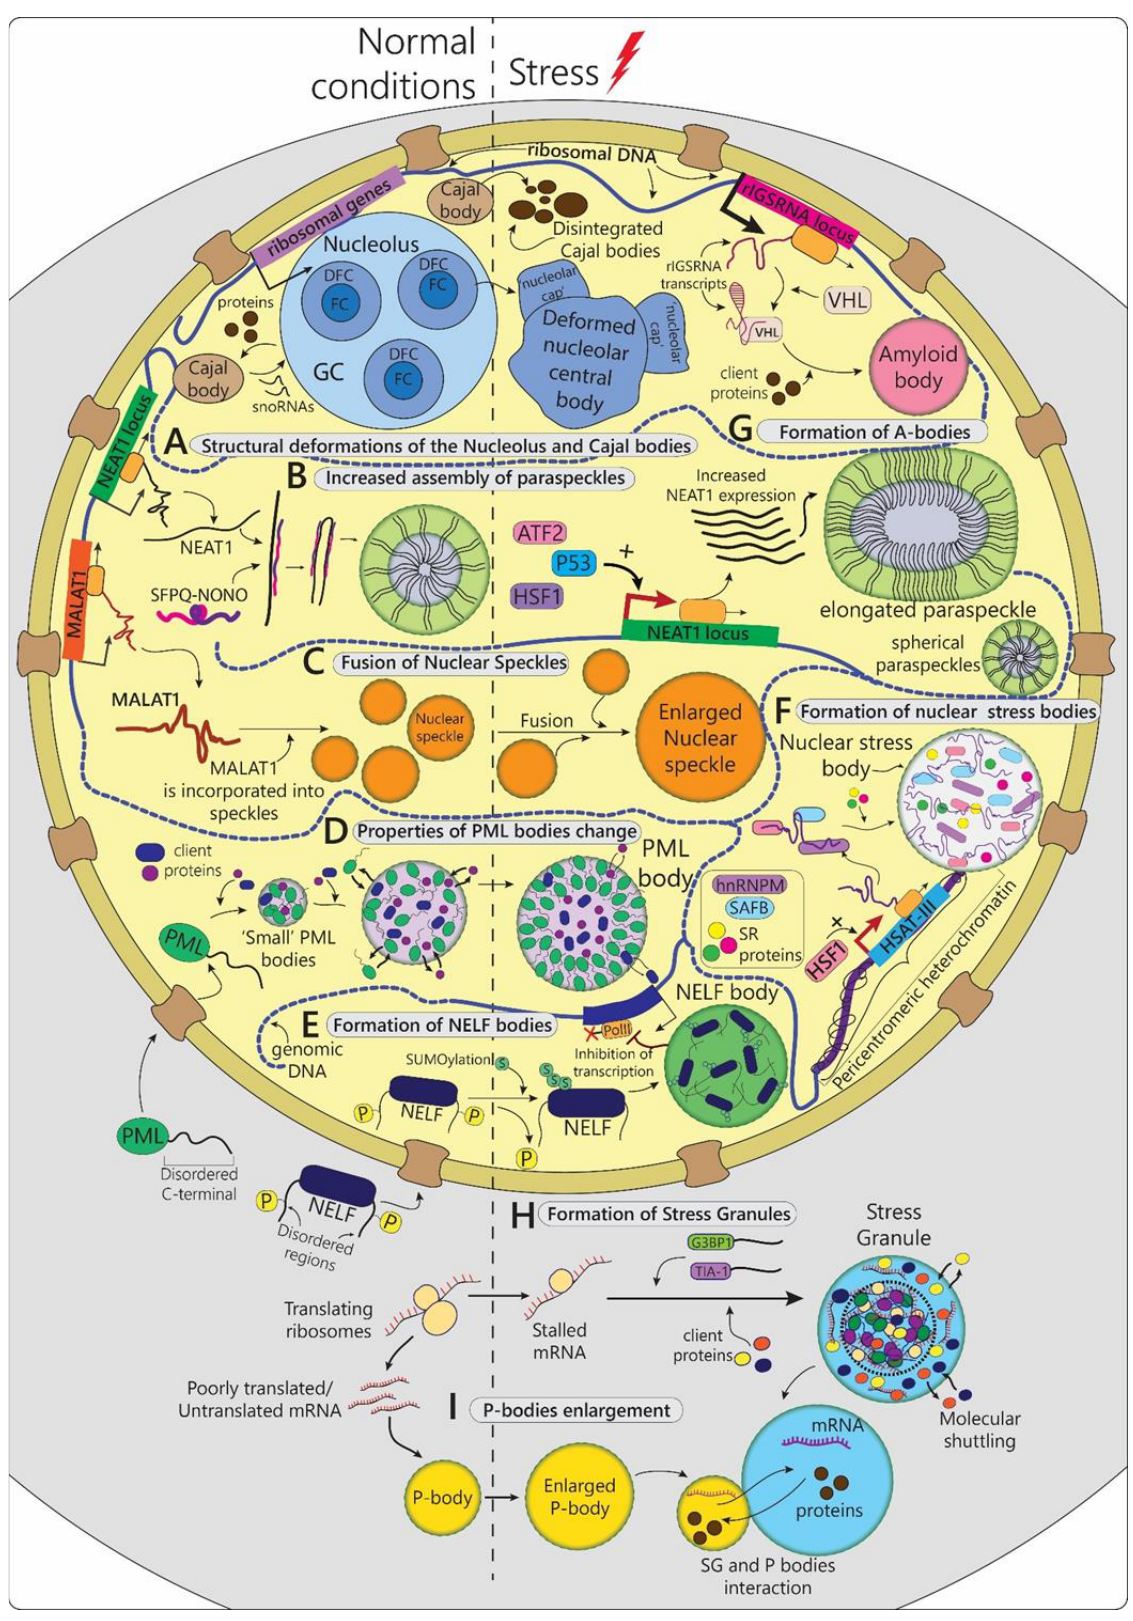
Figure 1. Illustration of biomolecular compartments formed or rearranged in response to stress in eukaryotic cells ( A – D ) Nuclear MLOs that undergo structural and functional changes in response